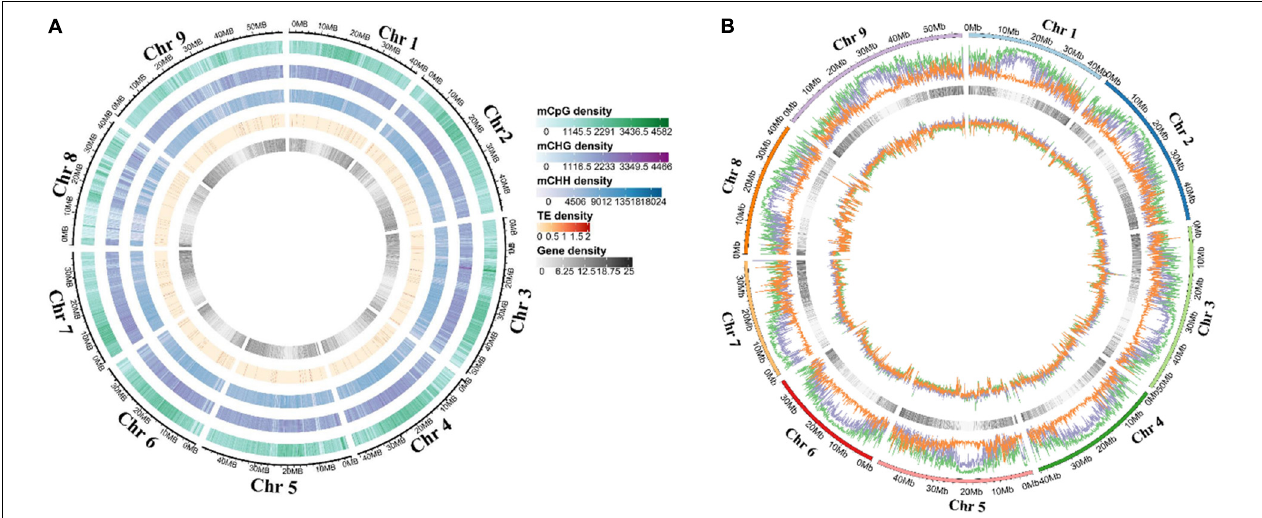
FIGURE 1 | Distribution of DNA methylation in each foxtail millet chromosome. (A) Circos plots of foxtail millet chromosomes. Track order: density plot of 5 mC in CG, CHG, and CHH contexts; density of TEs; gene density of each chromosome at the T1. (B) Density plot of 5 mC in CG (green), CHG (purple), and CHH (orange) contexts in the gene bodies on each chromosome at the